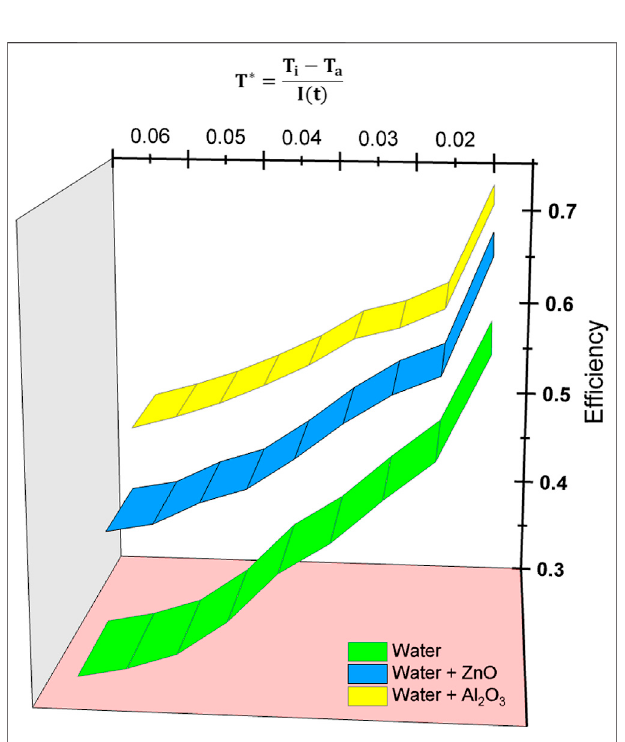
FIGURE 12 | The ef fi ciency of the solar collector.